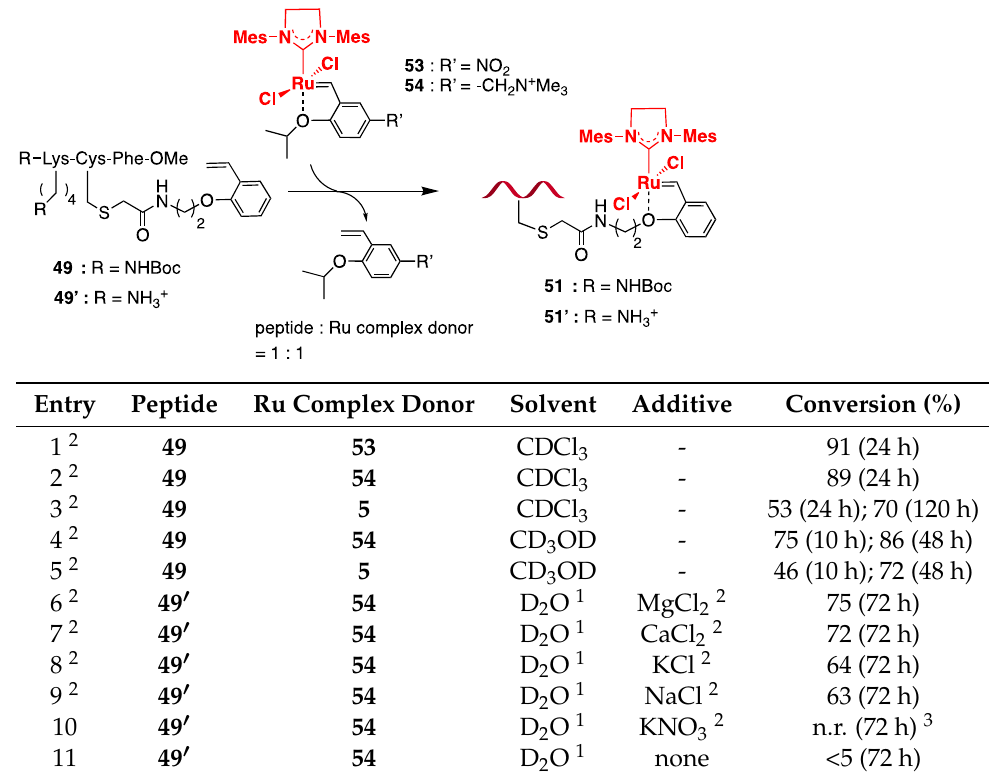
Table 6. Conversion values of the ruthenium complex transfer reactions [66].